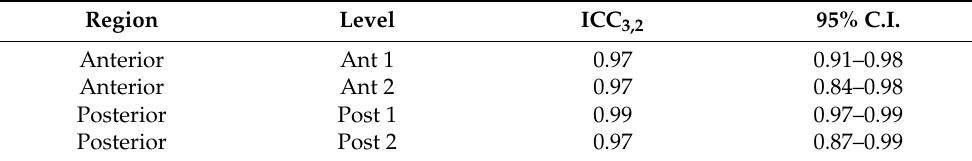
Table 2. Intra-rater reliability of the ultrasound measurements within different regions/levels of the deep fascia of the arm between two sessions by